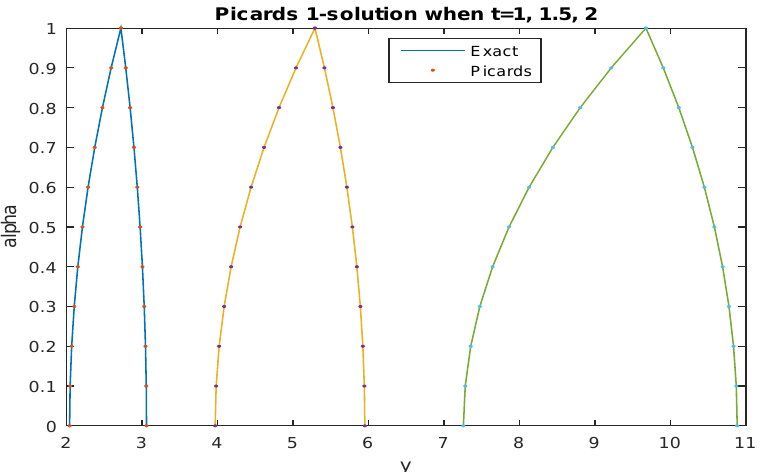
Figure 9. Exact(line) and Picard’s 1-solutions(stars) when t = 1.0, 1.5 and 2.0 with triangular shaped fuzzy numbers as the initial